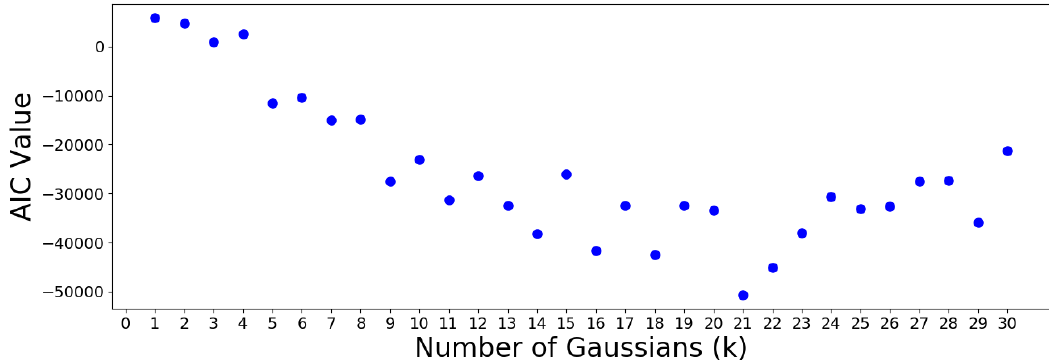
Figure 14. Akaike information criterion (AIC) values for Gaussian mixture models (GMMs) with cluster sizes 1 < K < 30. The minimum occurs at K = 21, which is selected as the desired number of